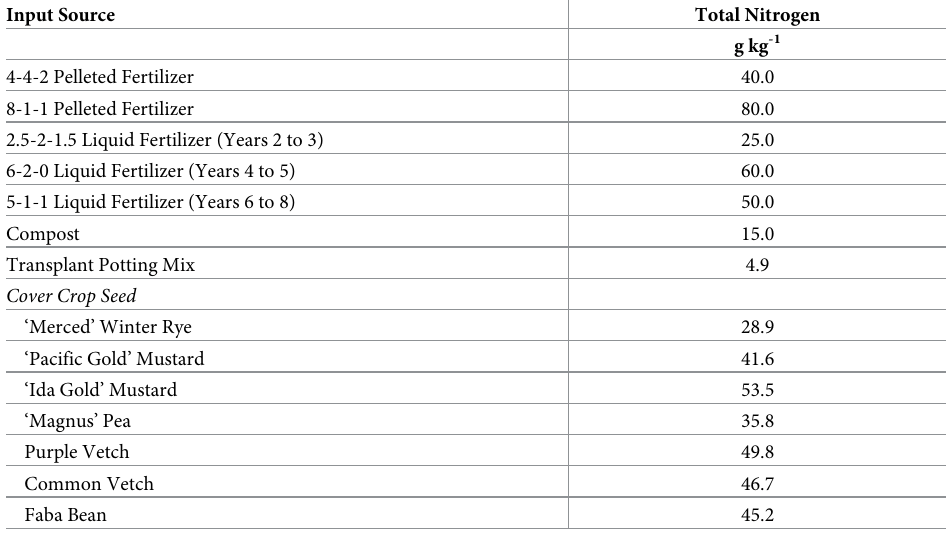
Table 2. Total nitrogen concentrations of inputs at the Salinas Organic Cropping Systems (SOCS)